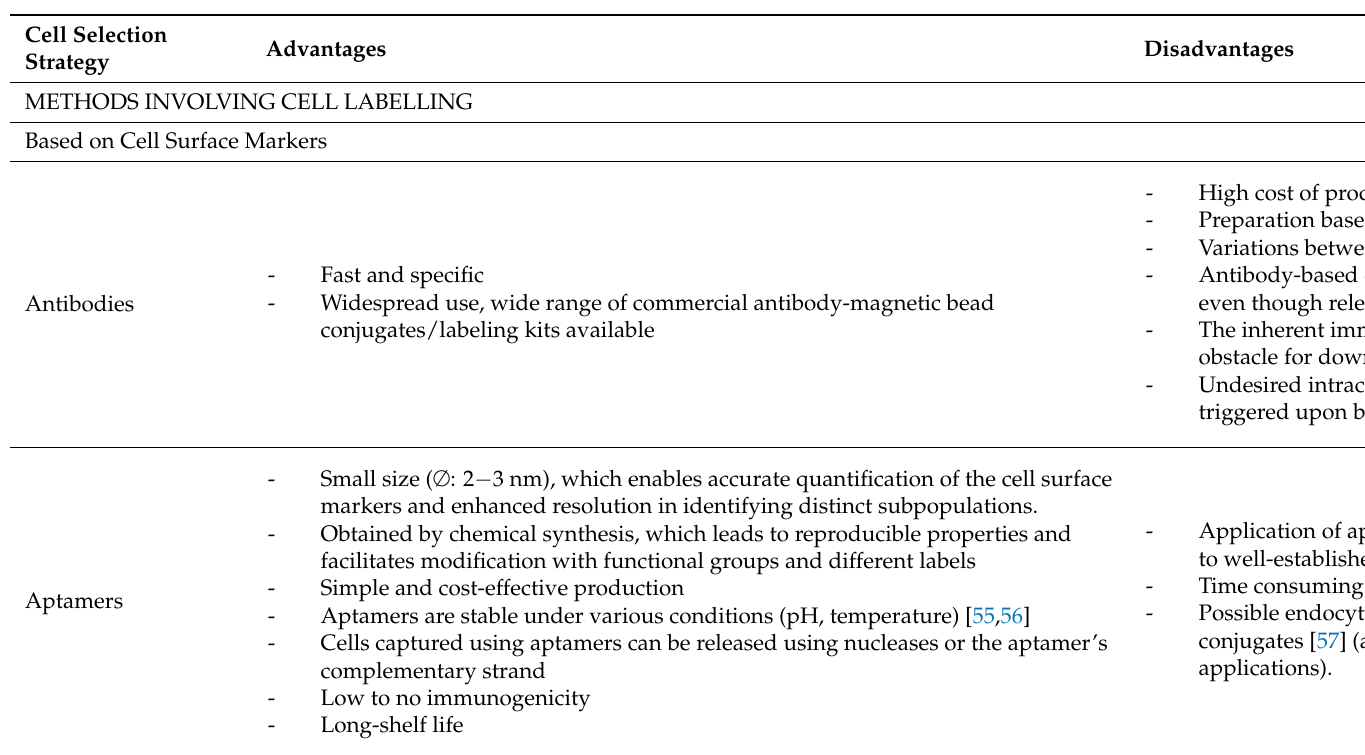
Table 1. Comparison of several cell selection